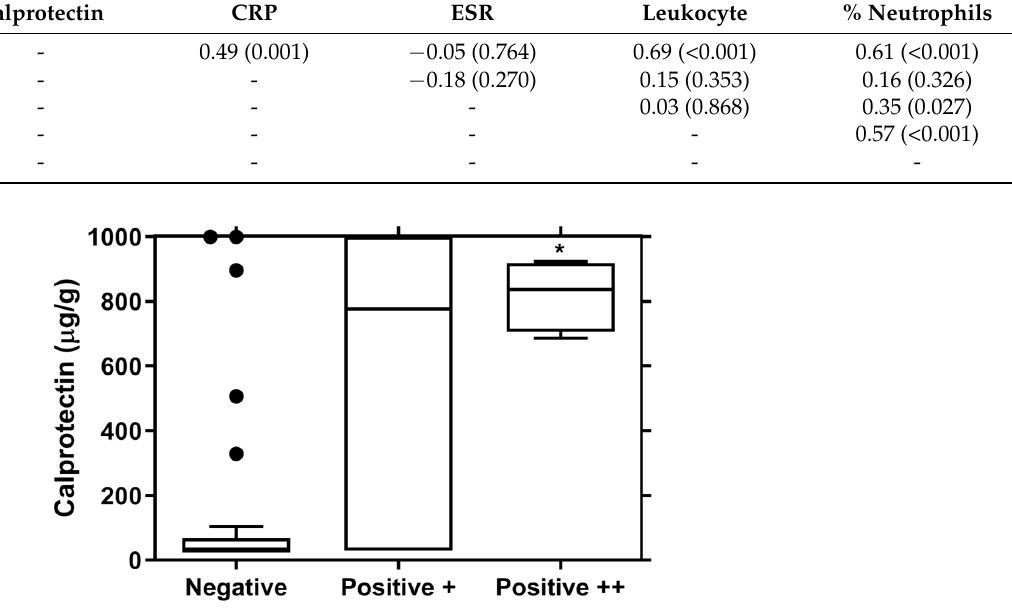
Figure 3. Calprotectin levels distribution in subjects with different results at the esterase test. POS+ and POS++ patients showed significantly higher levels of calprotectin compared to negative subjects. * p < 0.05 vs. negative subjects.